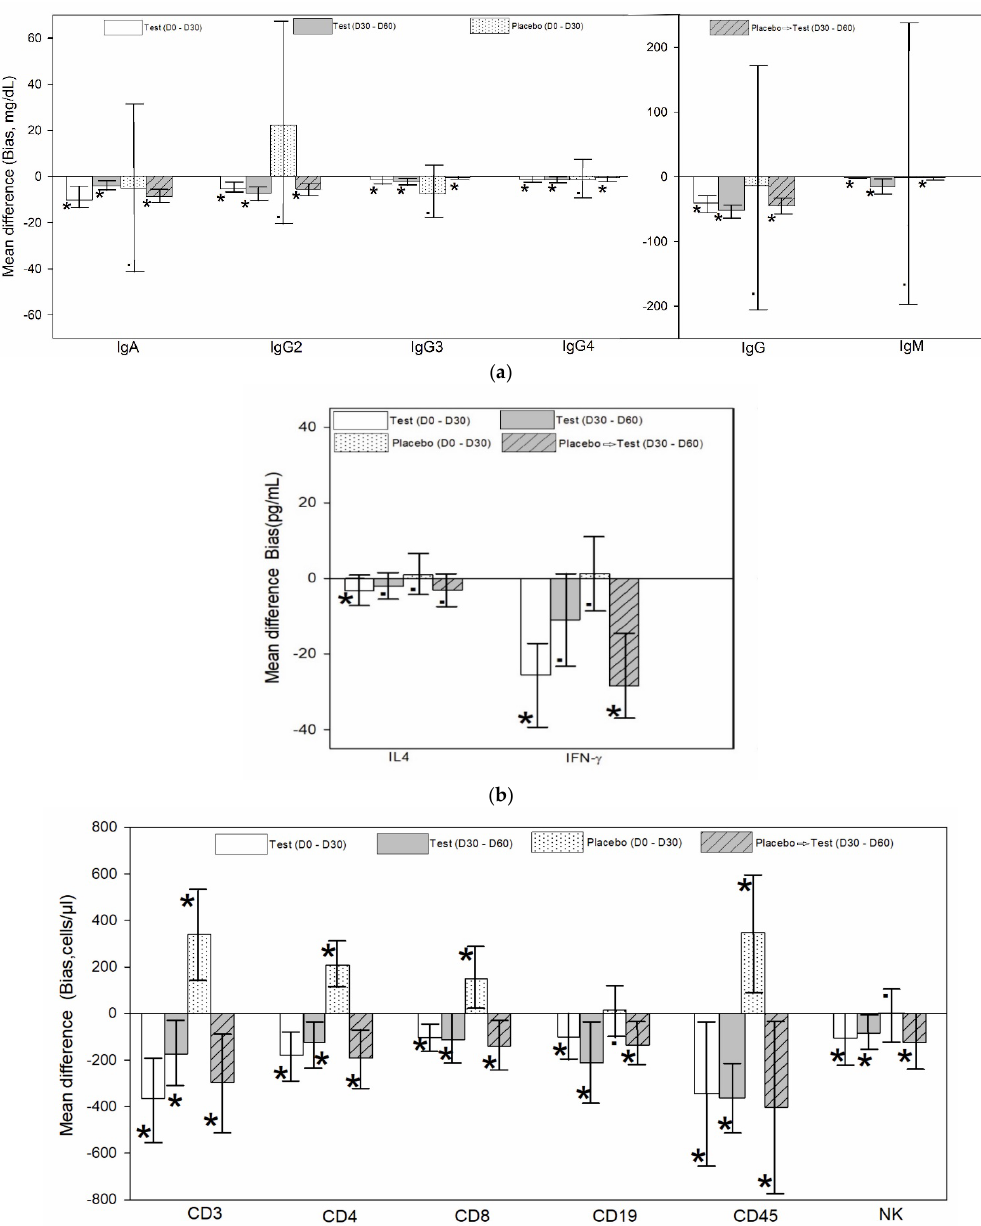
Figure 3. Representative figure for the Bland –Altman analysis data in participants treated with test (WS) and placebo. ( a ) Comparison of mean difference (bias) and confidence intervals for the bias of immunoglobulin level (mg/dL) in serum ( n = 12/group) for the study period (day 0–30) and extension period (day 30–60). The plots are represented in two scale ranges for better presentation of data. ( b ) Comparison of mean difference (bias) and confidence intervals for the bias of cytokine level (pg/mL) in serum ( n = 12/group) for the study period (day 0–30) and extension period (day 30–60). ( c ) Comparison of mean difference (bias) and confidence intervals for the bias of T cells (CD3+, CD4+, CD8+), B cells (CD19+), CD45+, and NK absolute cell counts (cells/ µ L) in whole blood ( n = 12/group) for the study period (day 0–30) and extension period (day 30–60). The data show the tip of the column corresponding to the mean difference (bias) and the whiskers showing confidence intervals for the bias. The data are taken from independent Bland–Altman plot generated for each parameter and period. (See Supplementary File 2 for actual Bland–Altman plot and tables for each parameter). Placebo (cid:212) Test indicates placebo group crossed over to the test group at the extension period of the study. * Significant at ( p < 0.05). • Not significant ( p >